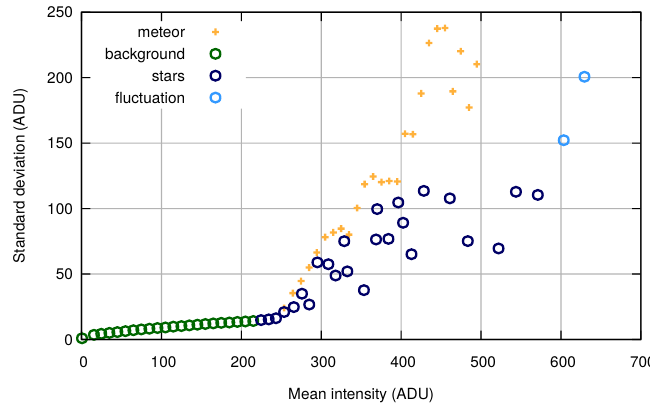
Figure 7. Comparison of statistical characteristics. ADU: analog-to-digital unit.